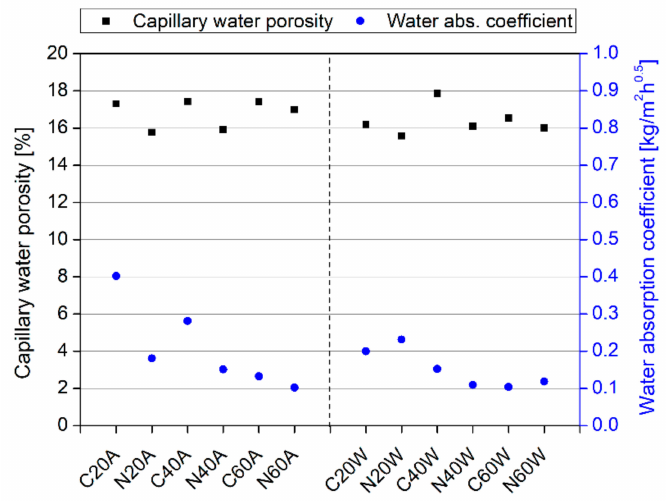
Figure 8. Transport properties of cement mortars after 180 days of